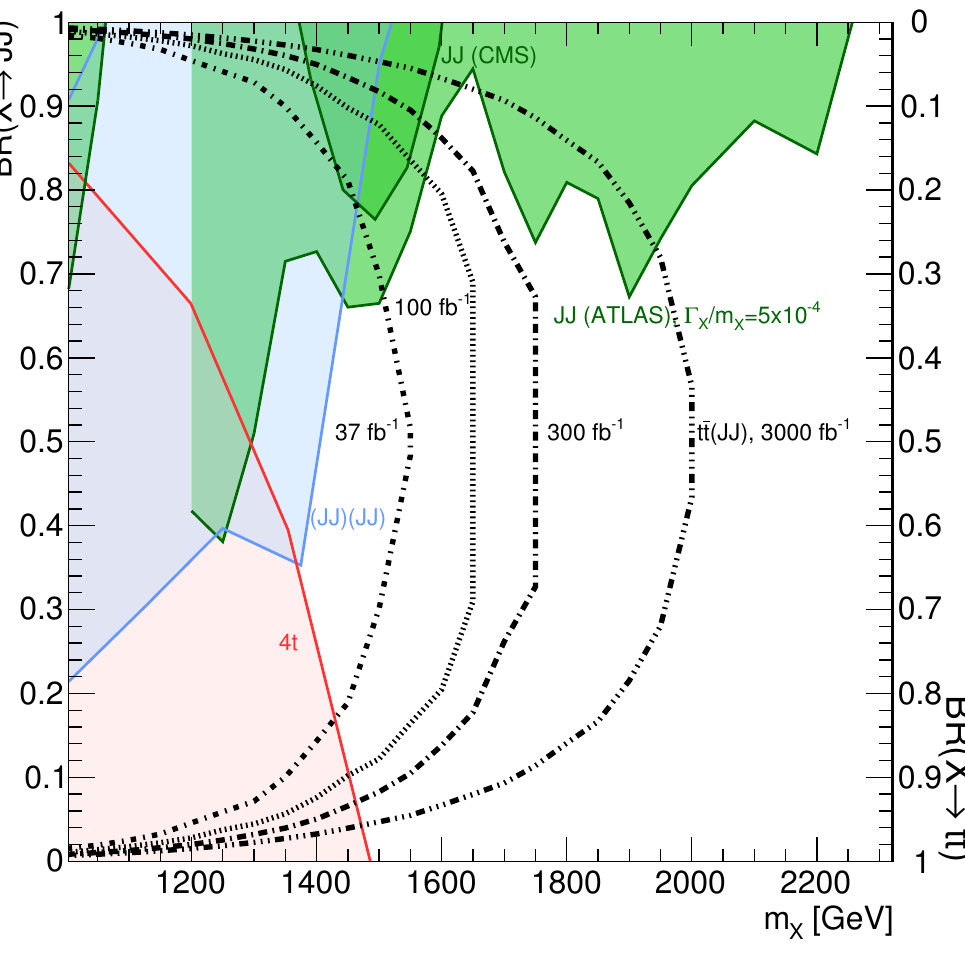
Figure 2 . Exclusion limits for di(cid:11)erent resonance masses as a function of Br( X ! JJ ) = 1 (cid:0) Br( X ! t (cid:22) t ). We show our limit in black for 37 fb (cid:0) 1 , 100 fb (cid:0) 1 , and 300 fb (cid:0) 1 of integrated luminosity, as well as the expected sensitivity at the HL-LHC with 3000 fb (cid:0) 1 . We also show current limits from 4 t (red) [38], ( JJ )( JJ ) (blue) [31], and ( JJ ) (green) [39, 40]